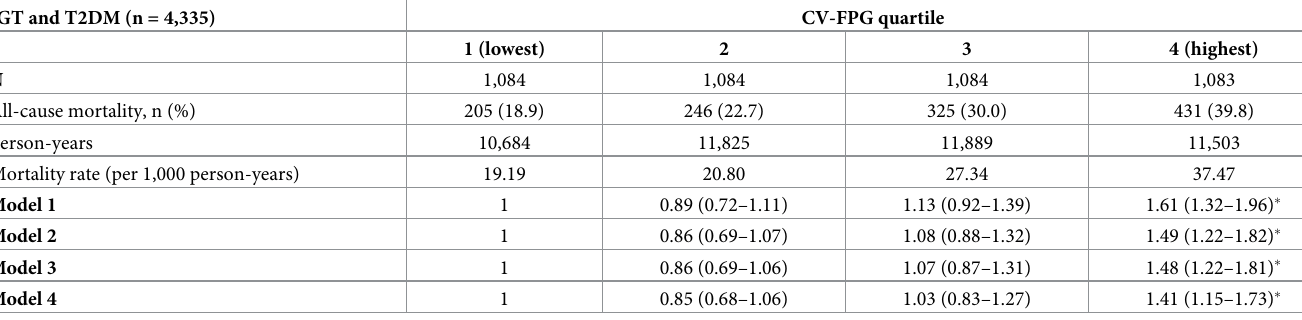
Model 1: adjusted for age and sex. Model 2: adjusted for age, sex, and history of cardiovascular disease. Model 3: adjusted for variables in model 2 plus hypertension, use of aspirin and statins. Model 4: Model 3 plus baseline FPG � p <